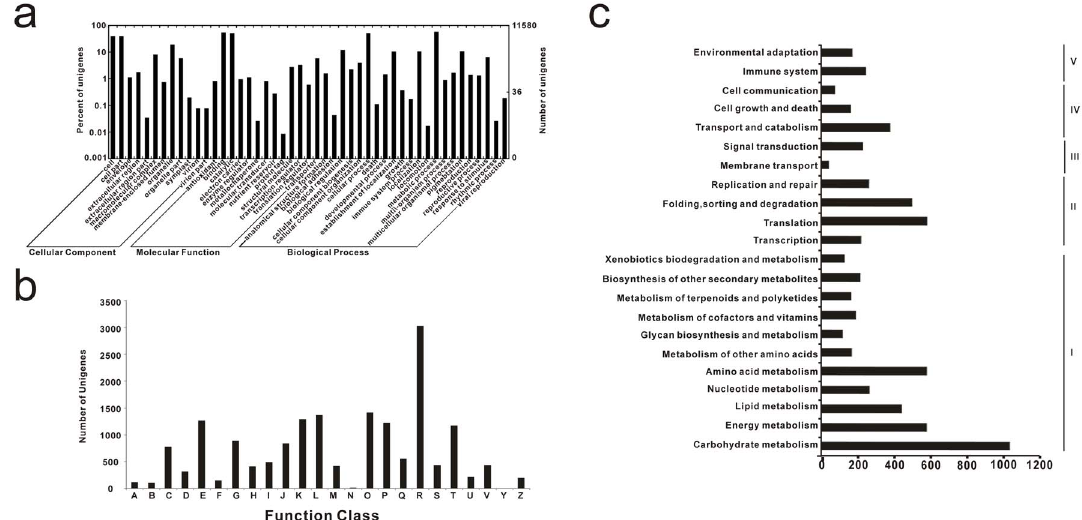
Figure 2. Annotation of common bean unigenes. a), GO annotation of common bean unigenes. The results are summarized in three main categories: biological process, cellular component, and molecular function. In total, 11,580 genes have been assigned 50 GO terms. In some cases, one gene has multiple terms. b), COG functional annotations of common bean unigenes. A, RNA processing and modification; B, Chromatin structure and dynamics; C, Energy production and conversion; D, Cell cycle control, cell division, chromosome partitioning; E, Amino acid transport and metabolism; F, Nucleotide transport and metabolism; G, Carbohydrate transport and metabolism; H, Coenzyme transport and metabolism; I, Lipid transport and metabolism; J, Translation, ribosomal structure and biogenesis; K, Transcription; L, Replication, recombination and repair; M, Cell wall/ membrane/envelope biogenesis; N, Cell motility; O, Posttranslational modification, protein turnover, chaperones; P, Inorganic ion transport and metabolism; Q, Secondary metabolites biosynthesis, transport and catabolism; R, General function prediction only; S, Function unknown; T, Signal transduction mechanisms; U, Intracellular trafficking, secretion, and vesicular transport; V, Defense mechanisms; Y, Nuclear structure; Z, Cytoskeleton. c), Histogram presentation of KEGG classification of unigenes. The all unigenes were assigned X pathways within X clades under five major categories: I, Metabolism; II, Genetic information processing; III, Environmental information processing; IV, Cellular processes; V, Organismal systems.